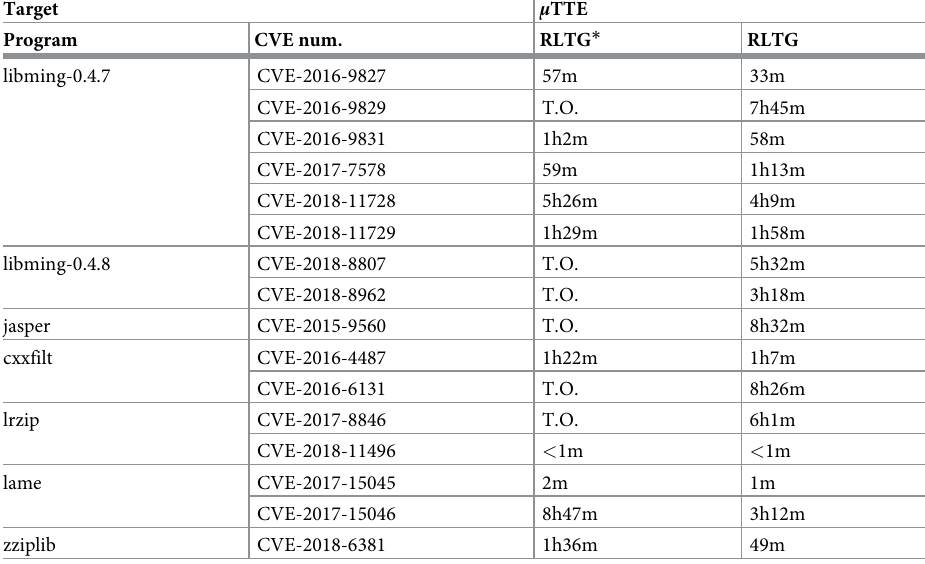
sented in Table 3. Table 3. Compares to RLTG * against the real-world programs using 10 repeated experiments for vulnerability